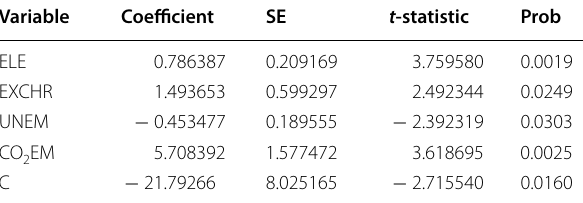
Table 7 Long-run results of